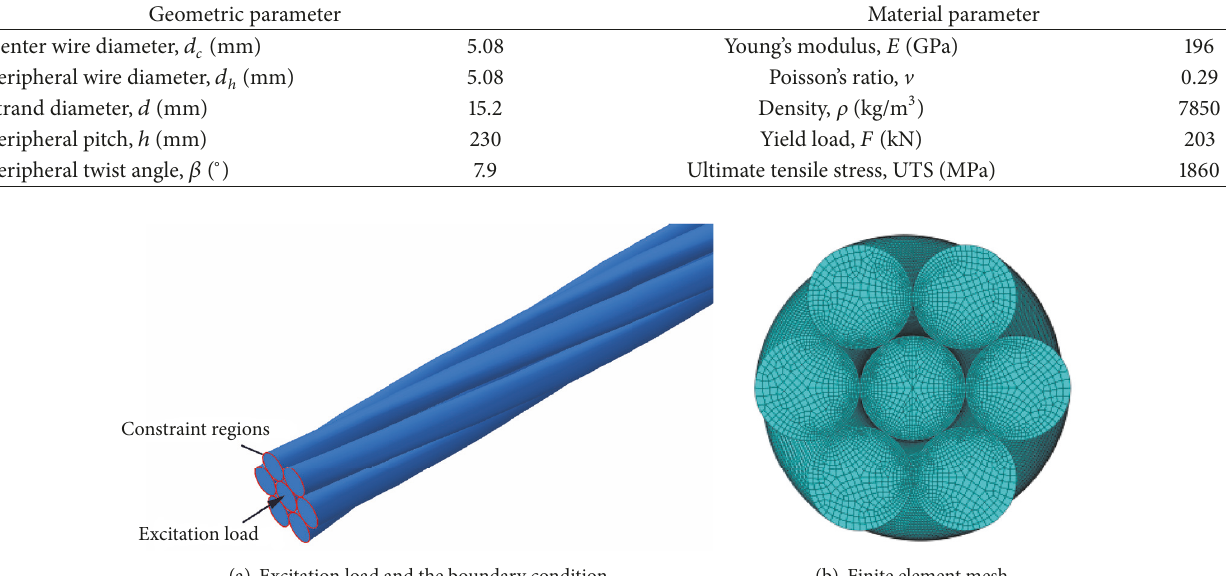
Figure 1: Finite element model for the seven-wire